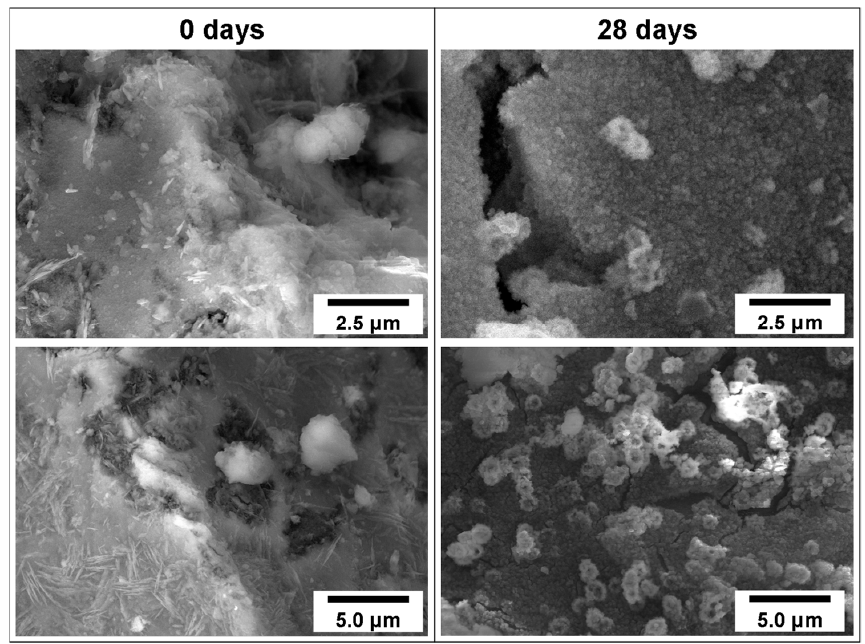
Figure 9. SEM images of powder (calcined at 600 °C) surfaces before (0 days) and after immersion in SBF for 28 days, confirming the formation of a carbonated hydroxyapatite layer. SBF for 28 days, confirming the formation of a carbonated hydroxyapatite